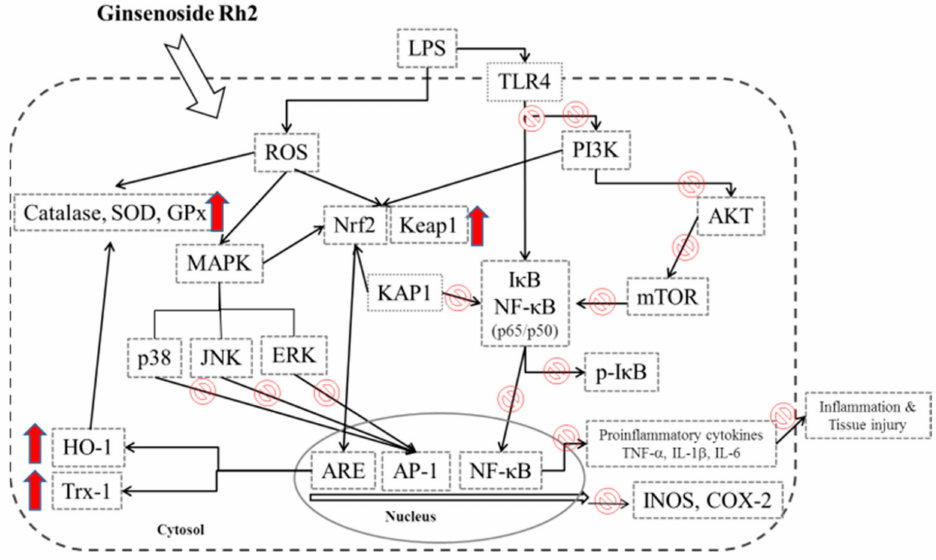
Figure 7. The schemes of the mechanism for the protective effect of GRh2 on LPS-induced